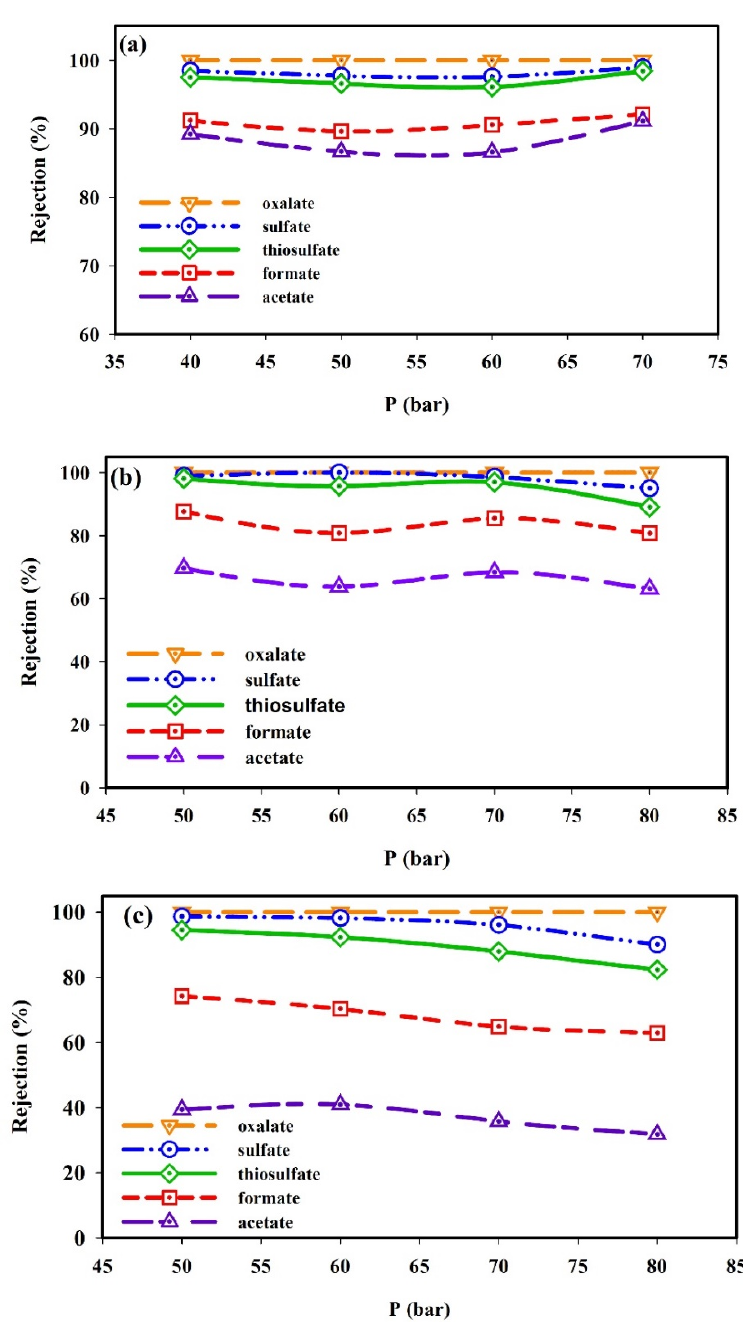
Figure 3. Effect of operating pressure on the rejection of multicomponent mixtures of ions in ( a ) 20 wt. %, ( b ) 30 wt. %, and ( c ) 45 wt. % of MDEA solution (temperature: 35 °C, pH = 10).